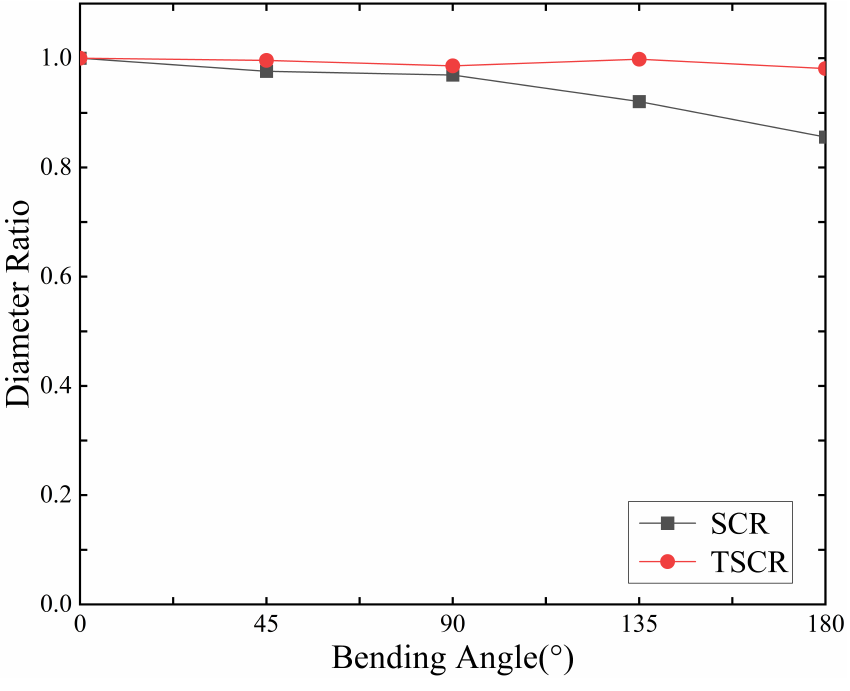
Figure 9. Central diameter ratio: soft continuum robot (SCR) and tuneable-stiffness soft continuum robot